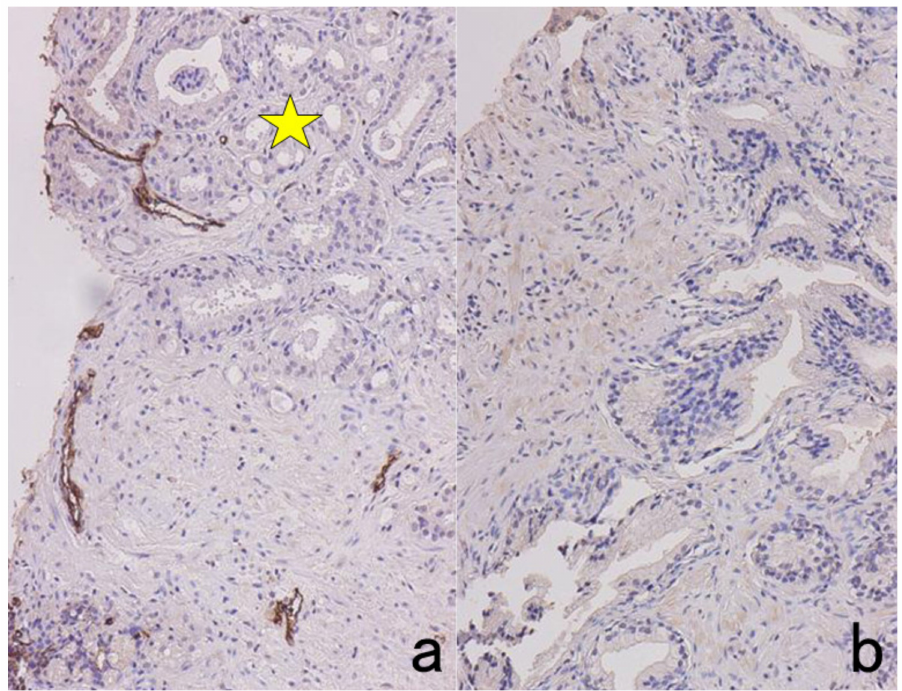
Figure 56. Immunohistochemical blood typing in needle biopsy specimens of the prostate. Specimens from two patients were mixed up in one tissue container. The blood group was type A in one patient and type O in the other. Immunostaining for type A substance is positive in endothelial cells in panel ( a ) but negative in panel ( b ). It is evident that the specimen of the patient with type A blood group contains well-differentiated adenocarcinoma